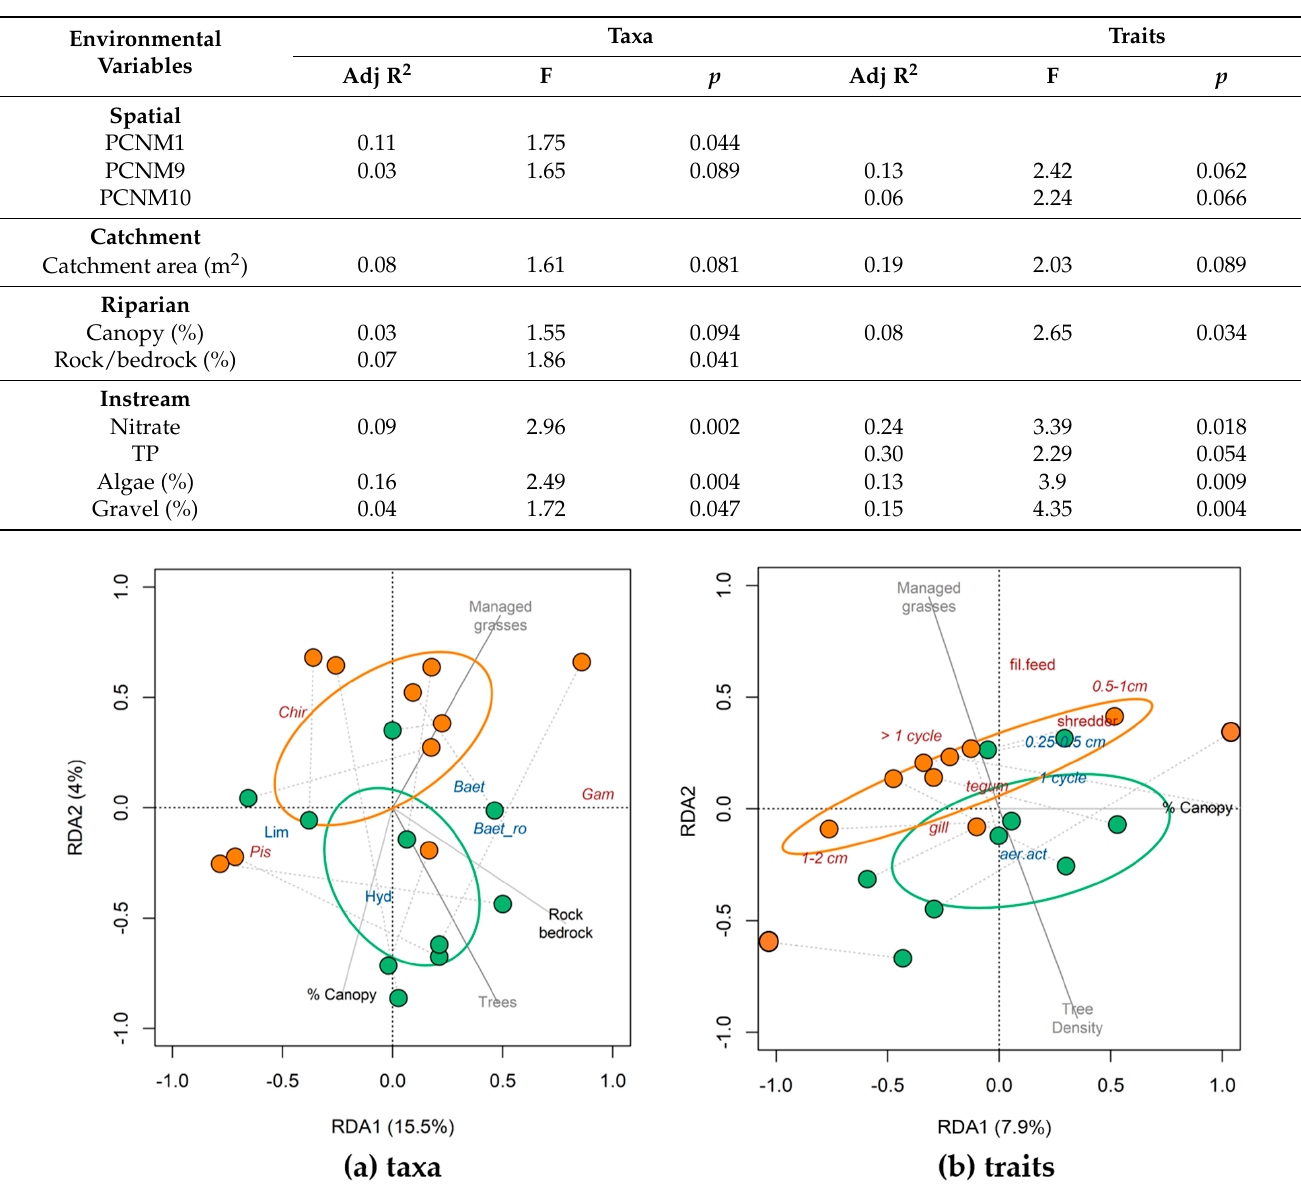
Figure 3. Results of pRDA for taxonomic ( a ) and trait ( b ) composition. Riparian attributes used in the pRDA are shown in black (% canopy, % rock/bedrock) and two riparian variables that are significantly different between the study reaches (% managed grass and % trees, based on t -tests) were shown in grey. The species and traits with the highest scores along the first two pRDA axes are shown in dark brown color (associated to unbuffered reaches with orange ellipse and orange dots) and blue color (associated to buffered reaches with green ellipse and green dots) color. RDA2 ( b ) is equivalent to PC1 axis, due to a one variable model (% Canopy). Taxa abbreviations: Baet = Baetis sp., Baet_ro = Baetis rhodani, Chir = Chironomidae, Gam = Gammarus pulex, Hyd = Hydropsyche siltalai , Lim = Limnius volckmari , Pis = Pisidium. Trait abbreviations: breathing: gills, tegum = tegument, dispersal: aer.act = aerial active; feeding: shredders, fil.feed = filter feeders; number of cycles per year: <1 cycle, 1 cycle; size: 0.25–0.5 cm, 0.5–1 cm, 1–2